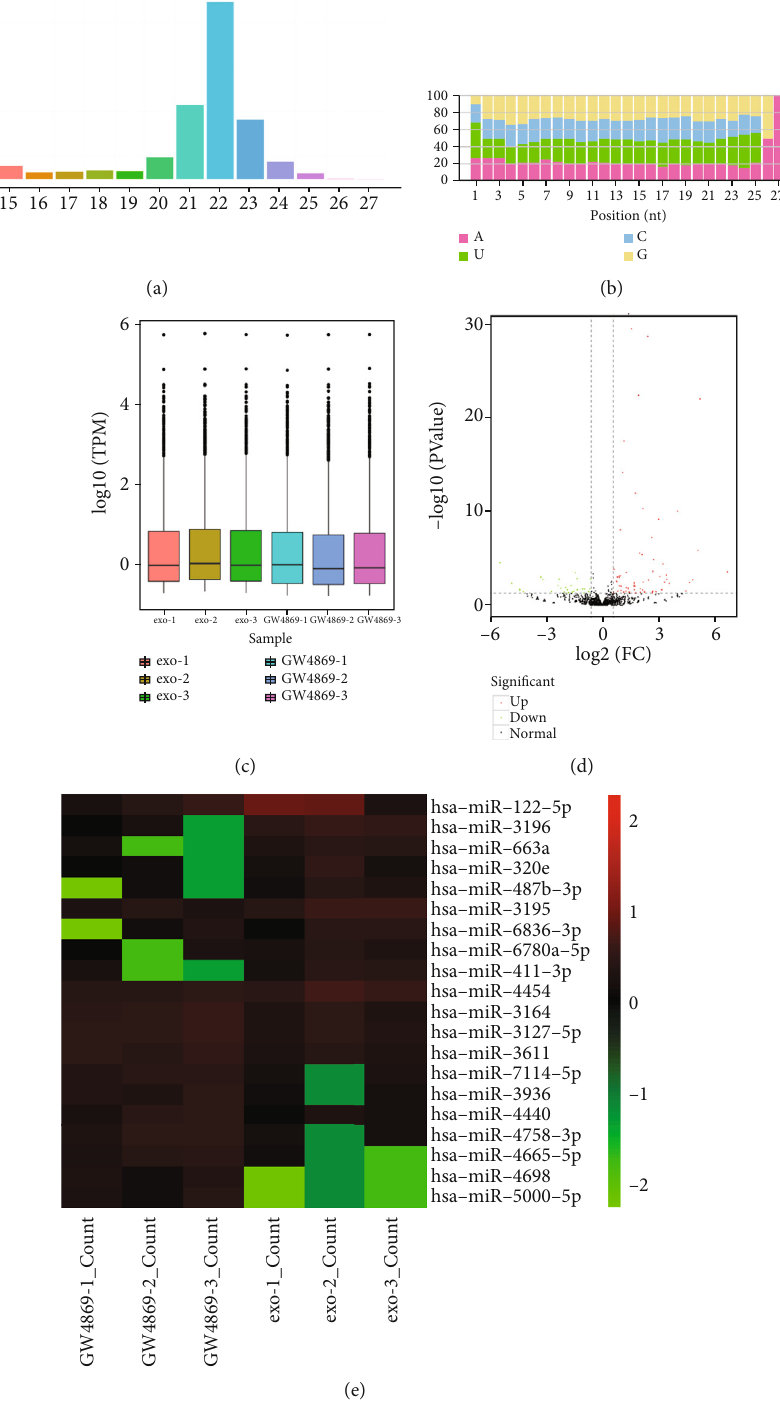
Figure 2: Di ff erentially expressed miRNA pro fi les between TGF- β 1-treated HK-2 cells treated with mesenchymal stem cell (MSC) supernatant+GW4869 and MSC-exo. (a) The length distribution of identi fi ed miRNAs. (b) The miRNA nucleotide bias at each position. (c) The overall distribution of the expression of each sample. (d) Volcano plot of the identi fi ed miRNAs. (e) Hierarchical clustering analysis of di ff erentially expressed